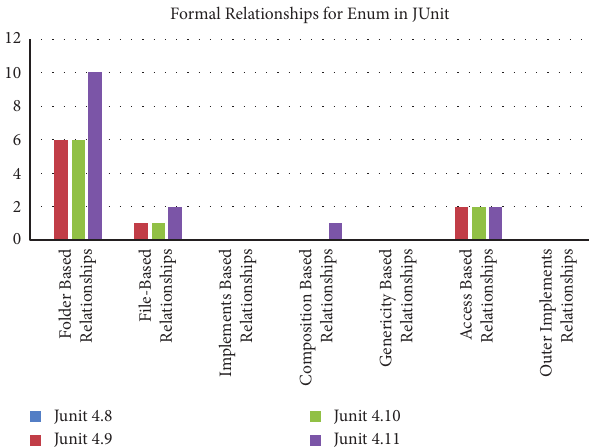
Figure 18: Count of formal relationships for enum in junit.